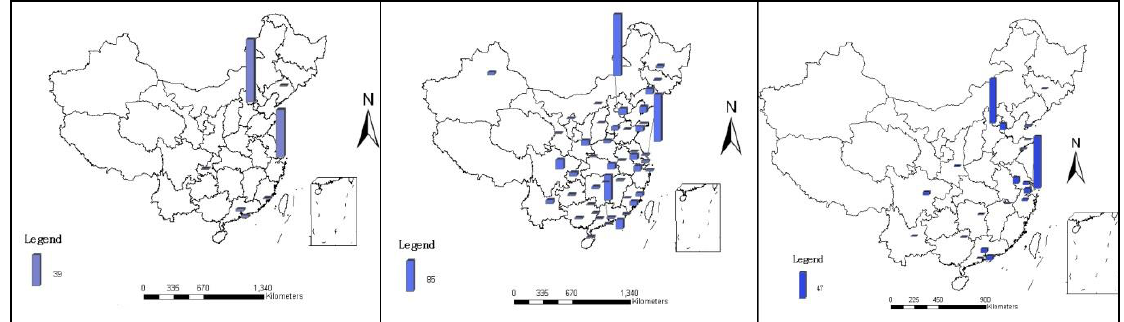
Figure 2 : Spatial Distribution of Regional Headquarters (Left) and Offices and Branches (Center) and Research and Development Centers